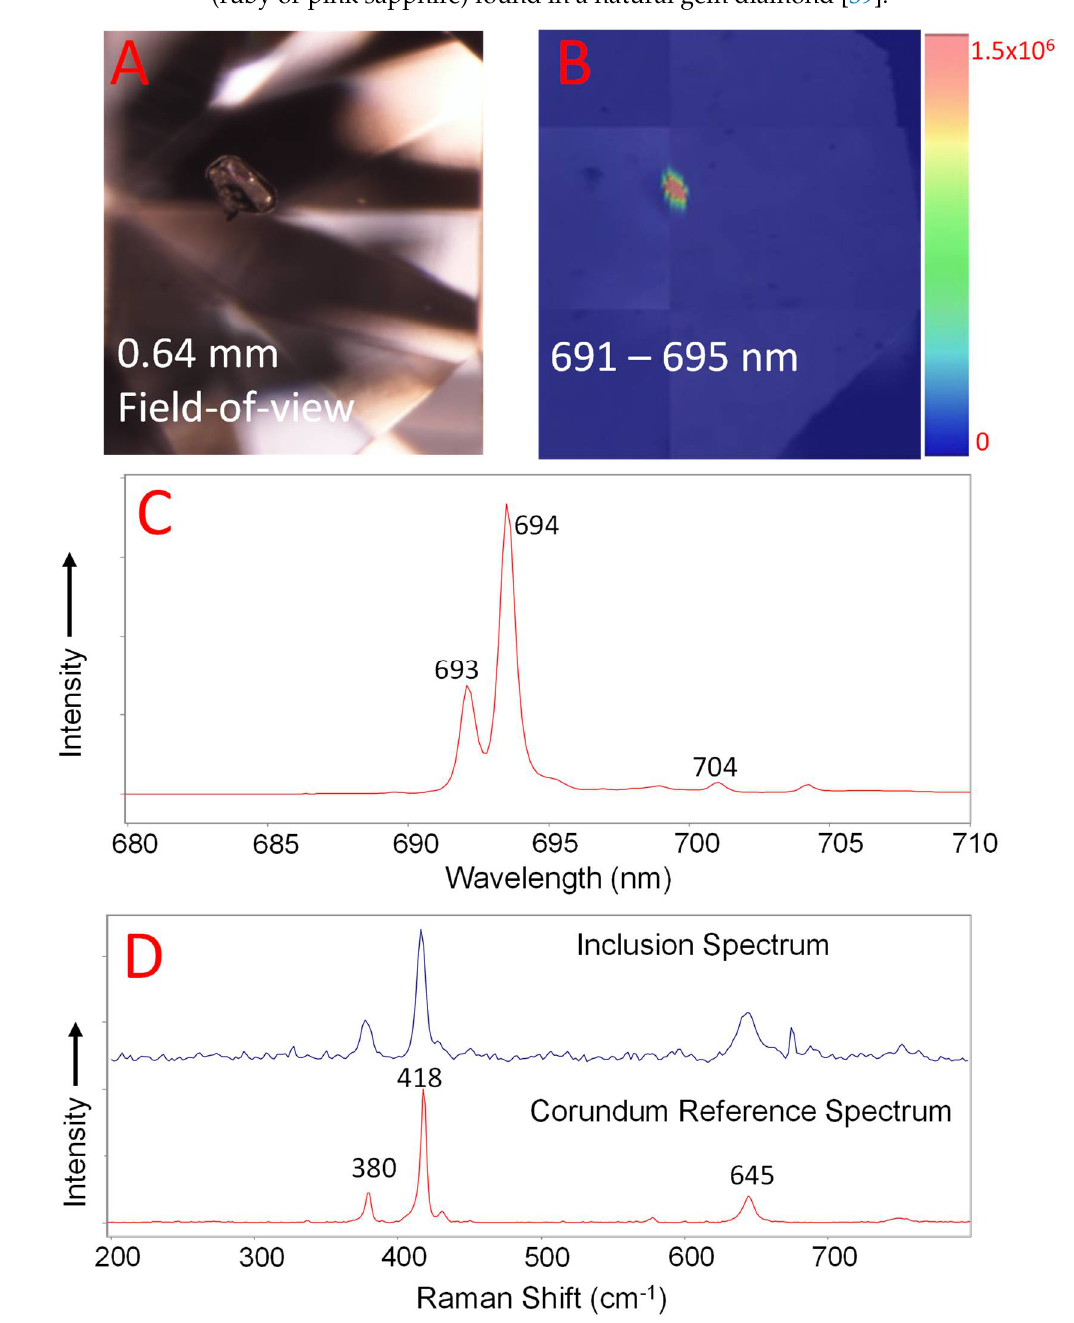
Figure 12. ( A ) A 0.13 ct diamond shown to have corundum inclusions. ( B ) Photomicrograph of the Table 693 nm chromium peaks (532 nm excitation). ( C ) Photoluminescence spectrum showing the detection of chromium with 532 nm laser excitation. ( D ) Raman spectra confirming the corundum identification. The blue trace shows the submitted diamond inclusion, while the red trace is a known corundum reference. Spectra vertically offset for clarity [39].